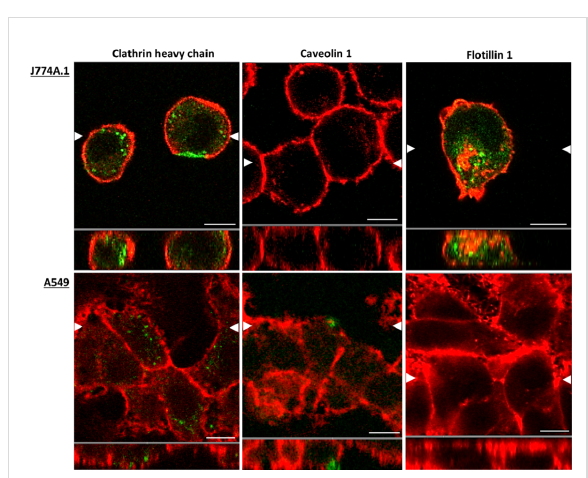
Figure 2: LSM images demonstrate the presence of the different endocytotic uptake proteins within J774A.1 macrophages and A549 epithelial cells. The LSM images show the presence of endocytotic proteins clathrin heavy chain, caveolin-1 and flotillin-1 in J774A.1 cells and A549 cells. The white arrows in the upper panel of each image (XY orthogonal plane) represent the position of the XZ slice shown in the lower picture. The apical side of the cells corresponds to the bottom line of the images. Endocytotic uptake proteins are shown in green and the actin cytoskeleton in red. Scale bar: 8